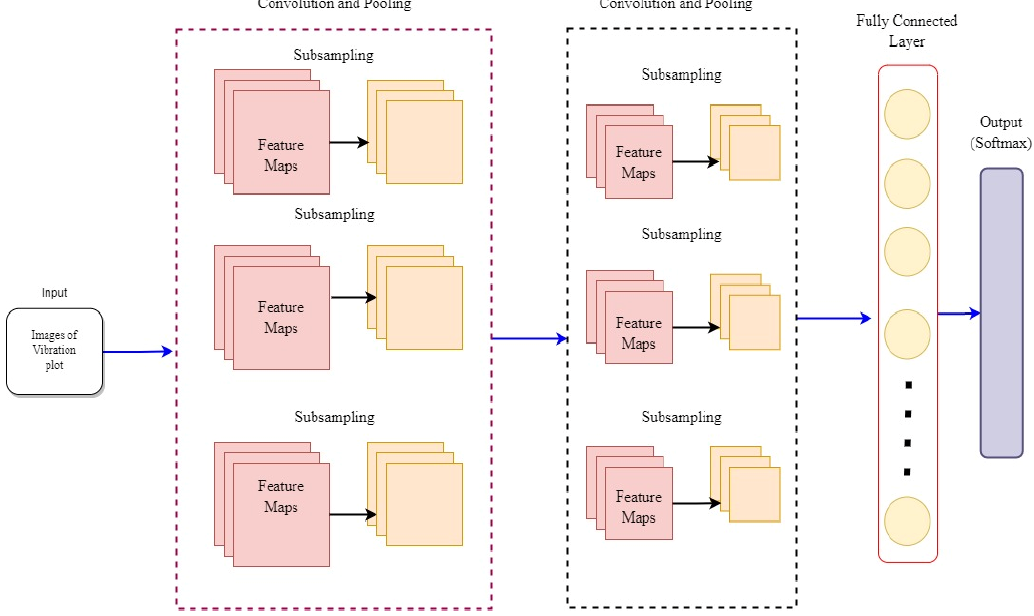
Figure 6. General architecture of CNN.